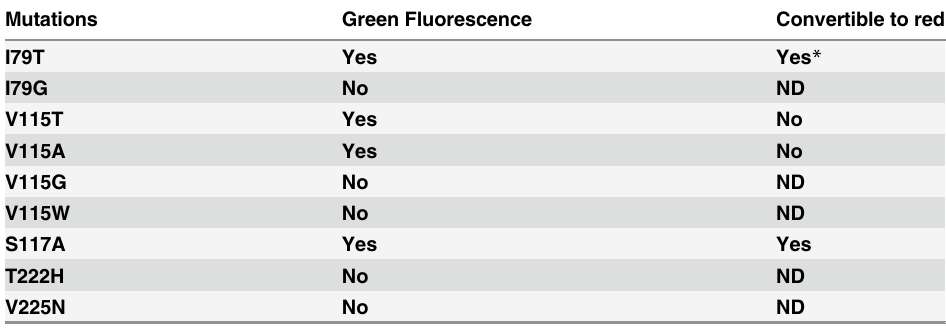
Table 1. Summary of Photoconvertibility of GCaMP3 Variants. Mutations Green